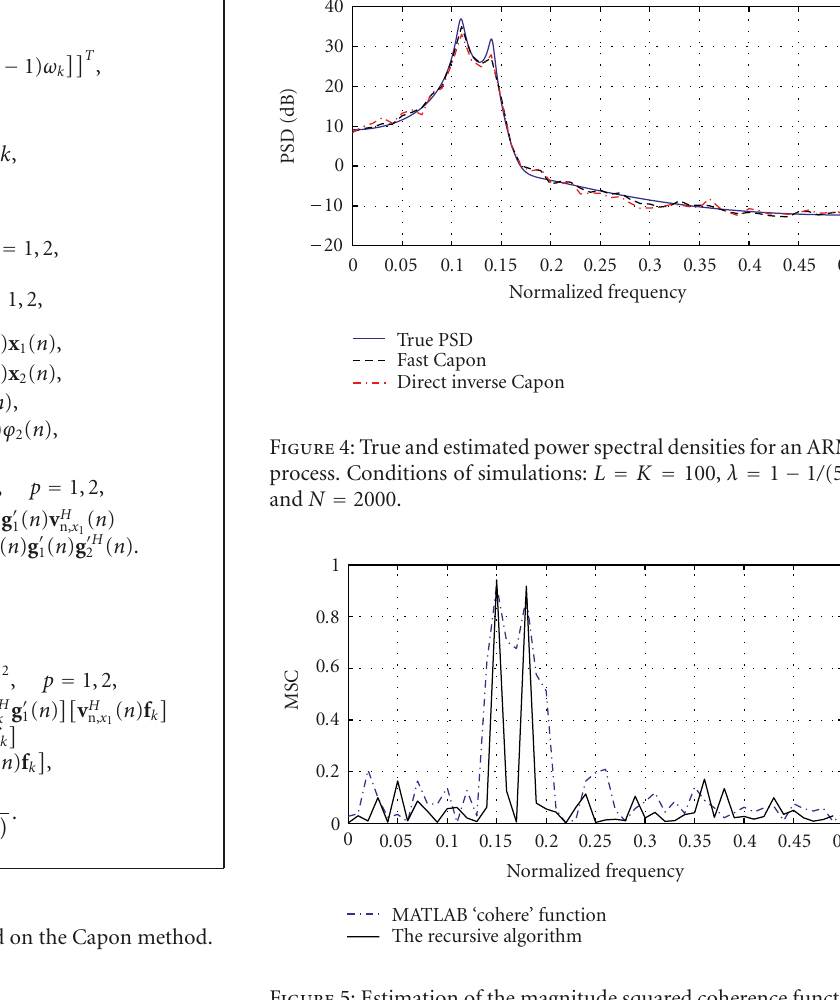
Figure 5: Estimation of the magnitude squared coherence function using both the Welch and the proposed approaches. Conditions of simulations: L = K = 100, N = 1024, and λ = 1 − 1 / (5 L